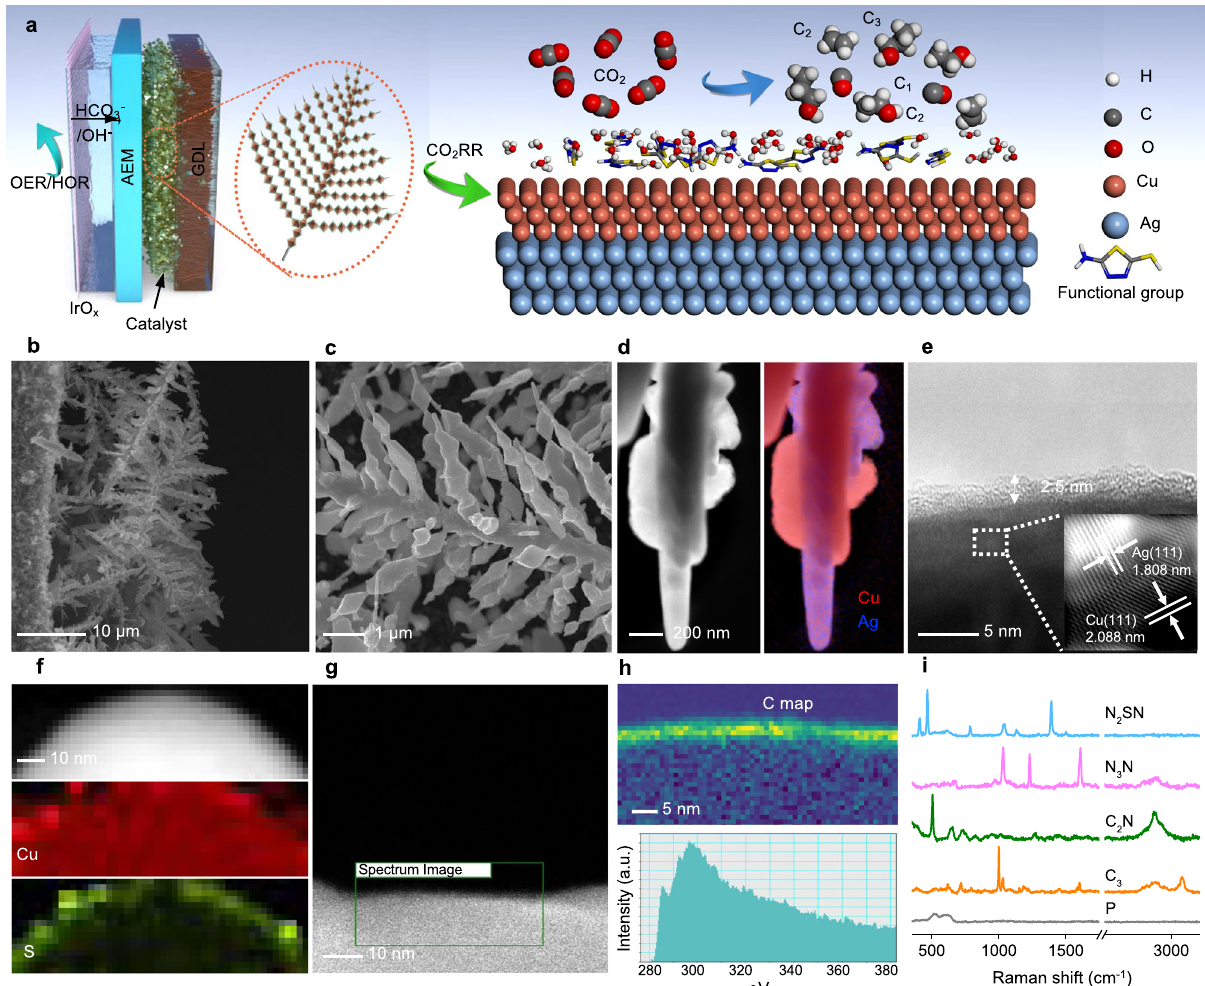
Fig. 1 Structural and elemental composition of the functionalized Ag – Cu catalysts. a Schematic representation of the functionalized Ag – Cu electrodes in a membrane electrode assembly. b , c Cross-section ( b ) and top-view ( c ) scanning electron microscope (SEM) images of the functionalized hierarchical Ag – Cu catalyst on a gas diffusion electrode (GDE). d High-angle annular dark- fi eld scanning transmission electron microscopy (HAADF-STEM) image (left) and corresponding Cu (red) and Ag (blue) EDS elemental maps of N 2 SN-functionalized Ag – Cu (right). e High-resolution transmission electron microscope (HR-TEM) micrograph of the N 2 SN-functionalized electrode ( e ). f HAADF-STEM image and the corresponding Cu and S EDS elemental maps taken from a section of Cu surface on the N 2 SN-functionalized Ag – Cu electrode. g HAADF-STEM image of the Cu surface of N 2 SN-functionalized Ag – Cu. h (top), Electron energy-loss spectroscopy (EELS) elemental mapping of C taken from the area marked by the box in g . h (bottom), EELS spectrum of the C-K edge with fi ne structures characteristics of carbon linked to heteroatoms from N 2 SN layer on the Cu surface. i Raman spectra of pristine (non- functionalized) Ag – Cu (gray), C 3 -functionalized Ag – Cu (orange), C 2 N-functionalized Ag – Cu (green), N 3 N-functionalized Ag – Cu (purple) and N 2 SN- functionalized Ag – Cu